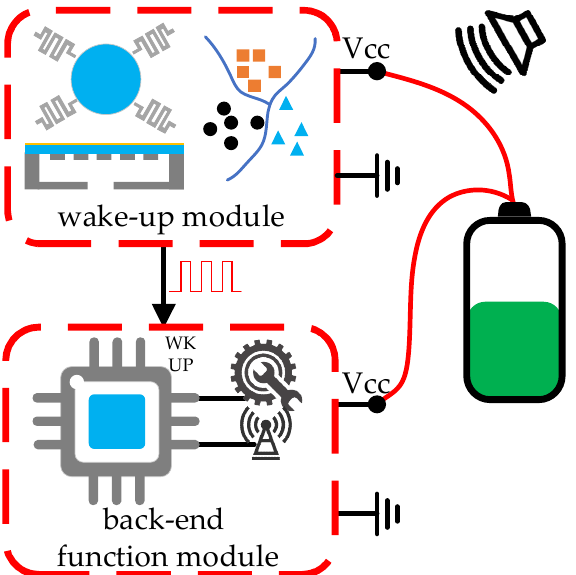
Figure 16. Architecture 1: low-power recognition and low-power sleep. An acoustic wake-up microsystem in this architecture is reported, which achieves target detecting, classifying, and tracking in the real wild area, as shown in Figure 17a [61]. The microsystem consumes 13.8 mW in sleep mode and has a long-term continuous monitoring capability of about 33 days. The whole weight including the battery is 145 g and the volume is 1056 cm 3 , which is a bit bulky for the microsystem. A simple acoustic wake-up microsystem with µ W-level power consumption is then reported, which is made up of a MEMS microphone and a readout circuit, as shown in Figure 17b [62]. When an acoustic event within the specific voice band occurs, the system wakes up and begins to output the acoustic data sensed by the microphone. Then, a mixer-based circuit and a low-power NN algorithm are applied to a microsystem to achieve acoustic recognition with nW-level power consumption, as shown in Figure 17c [63]. Both speech and non-speech detections are realized, with a power consumption of 142 nW. When a target event is detected, the system is activated to a high-performance mode. Among all the acoustic wake-up microsystems with Architecture 1, a 12 nW microsystem is the one with the lowest power consumption, as shown in Figure 17d [64]. By optimizing the power consumption of algorithm-circuit and electronic components, the microsystem realizes acoustic event identification with 12 nW consumption. In addition to the applications on land, there is also a report for the underwater application. An acoustic wake-up microsystem containing machine-learning algorithm runs on an onboard microcontroller, and different acoustic signals are classified with an accuracy of up to